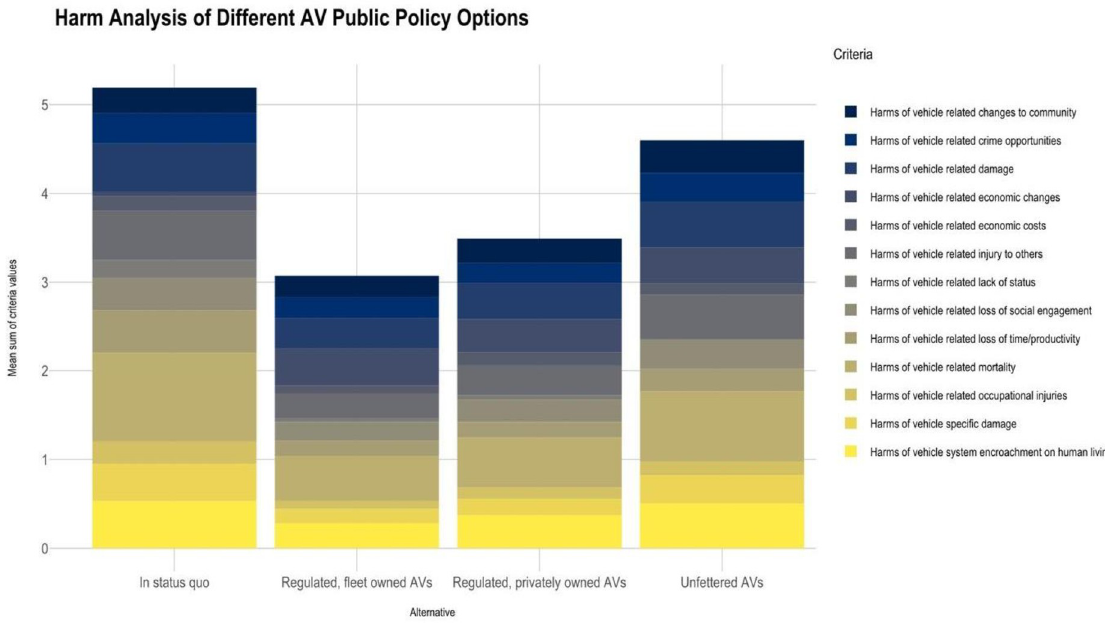
Fig 1. Harms of different AV technology implementation, 4-point scale.